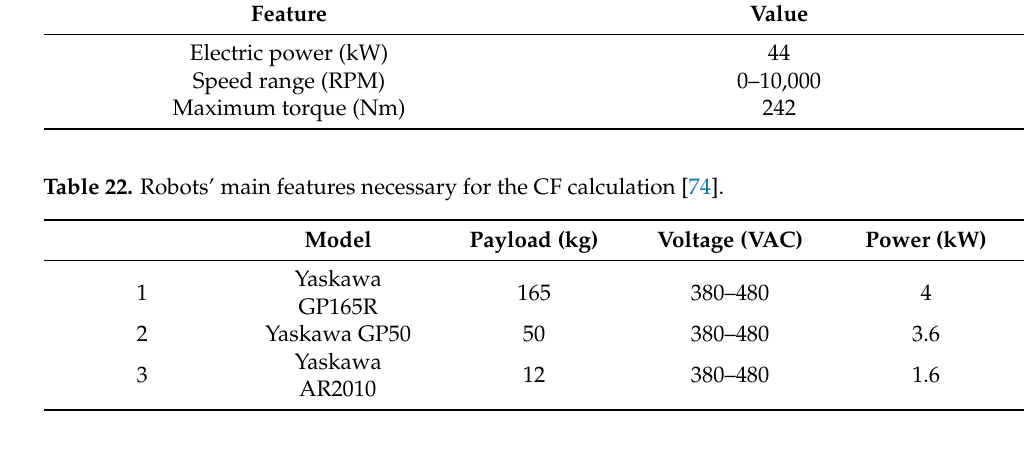
Table 23. Number of estimated/assumed operators involved in production.